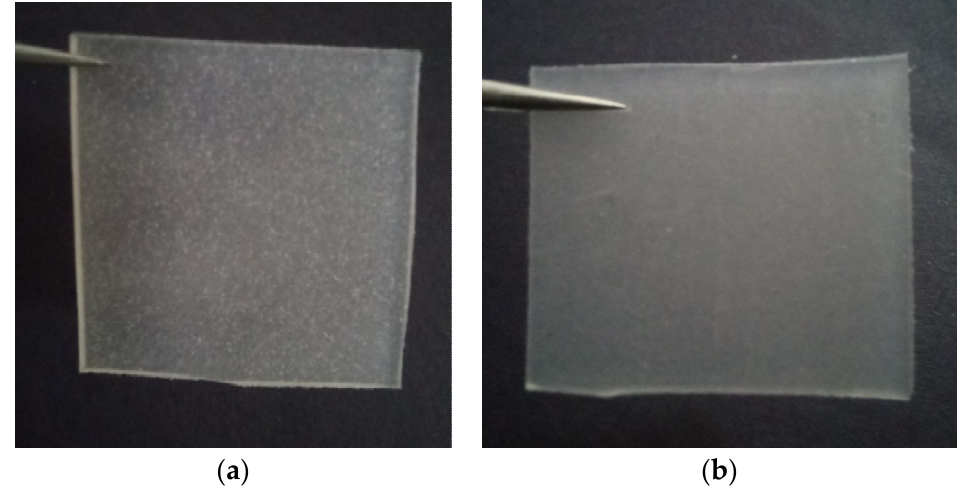
Figure 9. ( a ) Polyethylene-co-vinyl acetate (PEVA) composite with pulverized dolomite (particle size = 150 µm). ( b ) PEVA composite with ground dolomite (particle size ≤ 63 µm) (own photograph through own research)